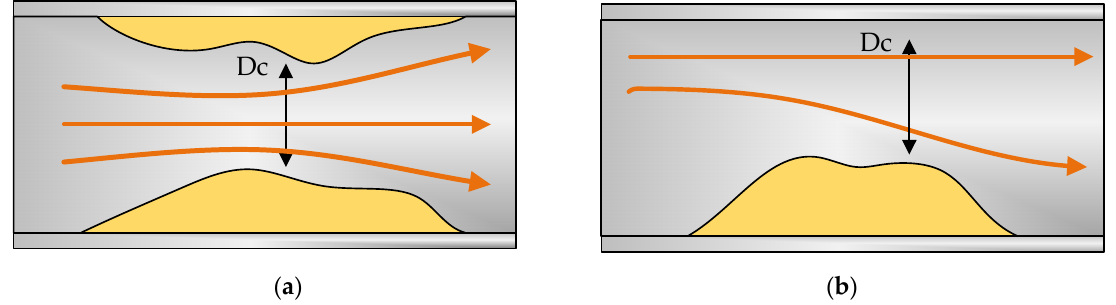
Figure 5. Partial blockage: ( a ) the salt has solidified all around the entire surface of the pipe, ( b ) the salt has been deposited on a specific area of the pipe. Both blockages define the same section.